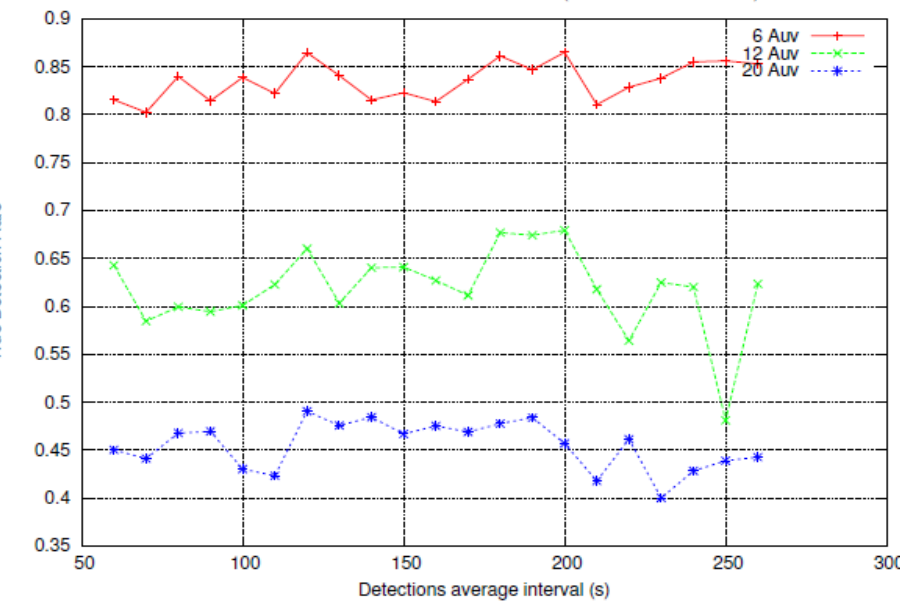
Figure 9. Percentage of True Detection against detection interval, for different number of